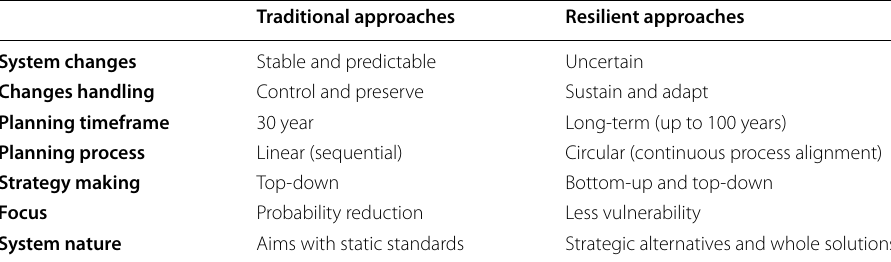
Table 1 Traditional vs resilient approaches. Ref: adopted from Zevenbergen et al.